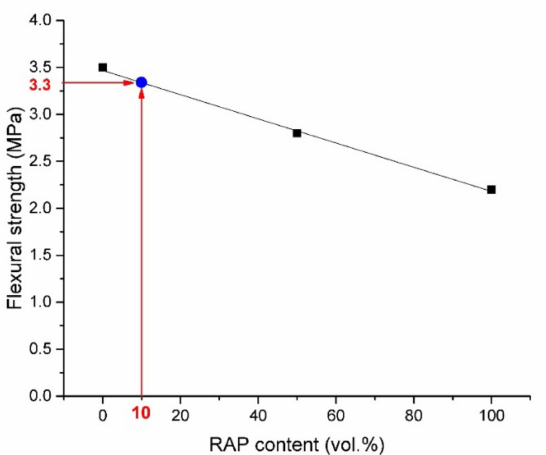
Figure 6. Flexural strength development of concretes with a di ff erent content of the RAP